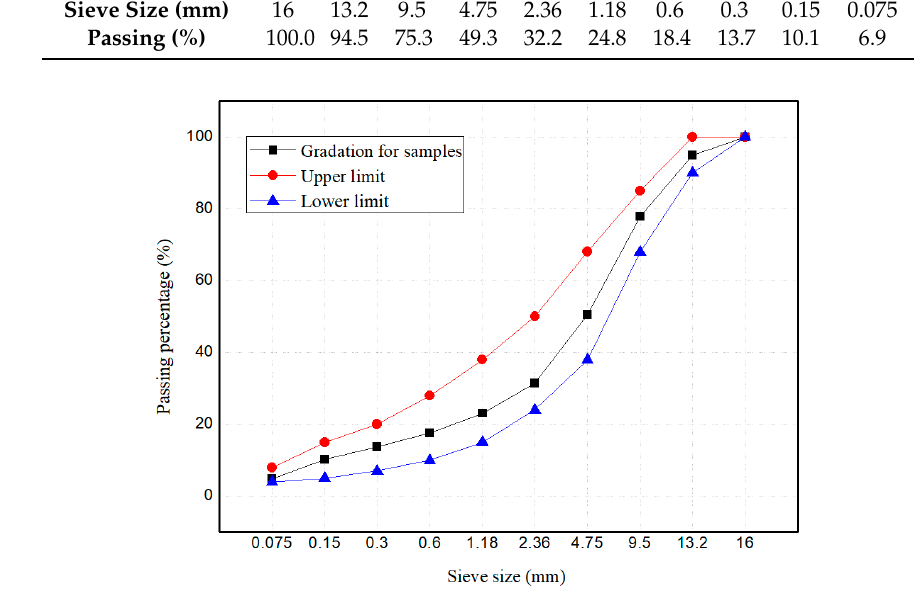
Figure 2. Gradation of the AC ‐ 13 mixture.